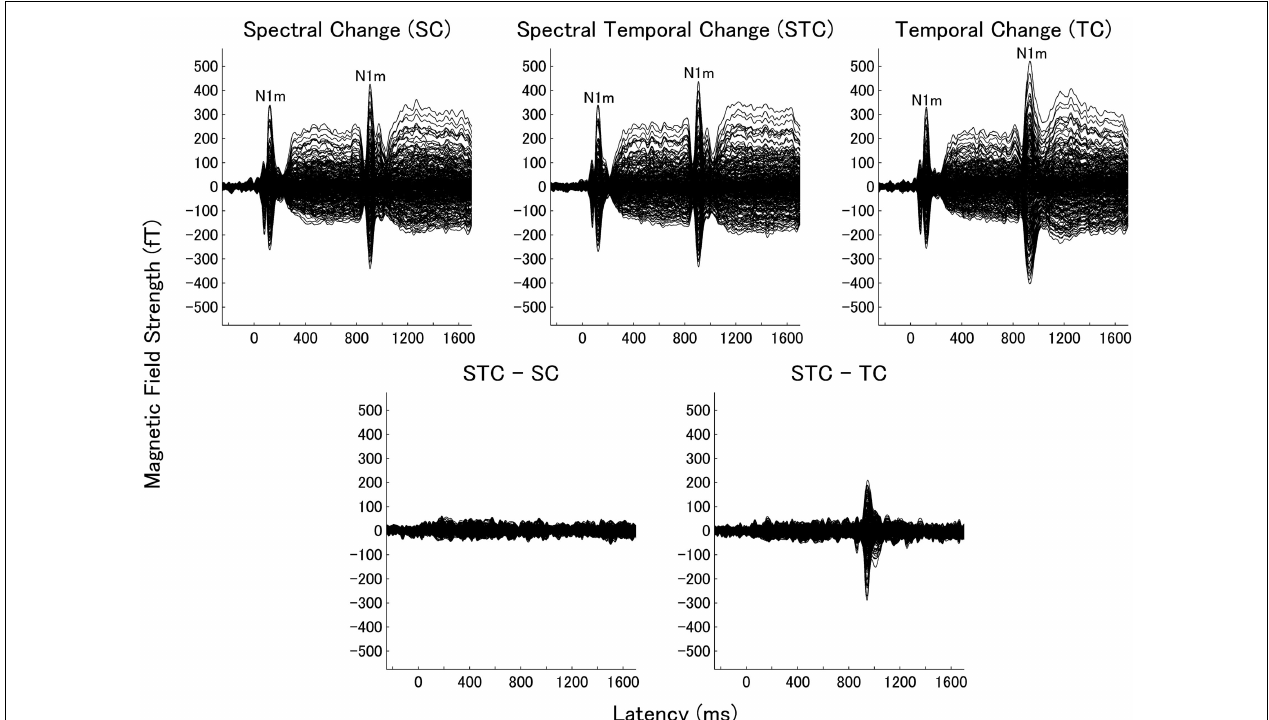
spectral–temporal change (STC: middle), and temporal change (TC: right).The lower panels show the difference waveforms between STC and SC (STC – SC: left) and between STC andTC (STC –TC: